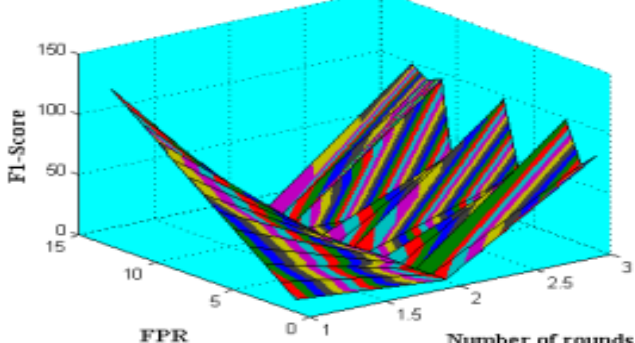
Figure 10. F1-score vs. number of rounds.